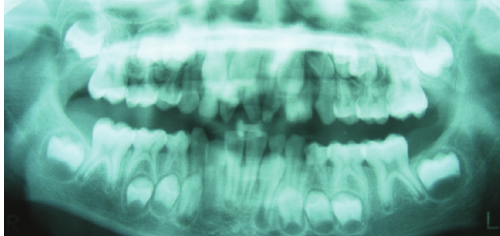
Figure 7: Panoramic radiograph showing bilaterally erupted sup- plemental mesiodentes; fusion of 61 and 62 and missing